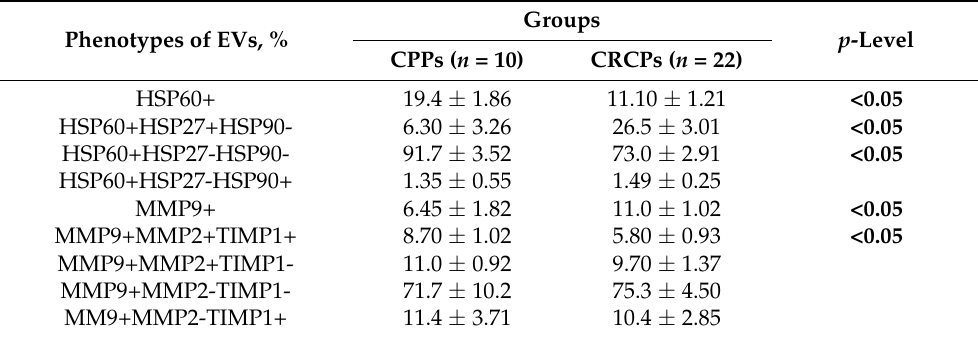
Table 1. MMPs and HSPs composition on the surface of CD9-positive sEVs in blood plasma in CPPs and CRCPs, mean ± SE